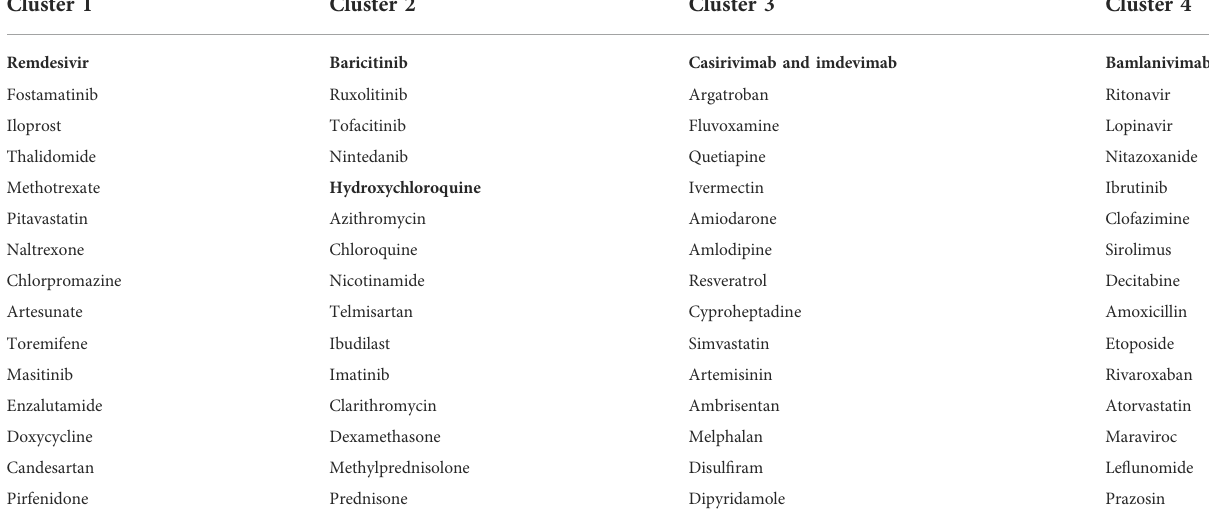
TABLE 2 Four drug clusters based on the integrated drug – drug similarity network and NMF outcomes of the CEUAFD. Drugs in bold are from the CEUAFD, and each drug cluster features one speci fi c AE signature. Cluster